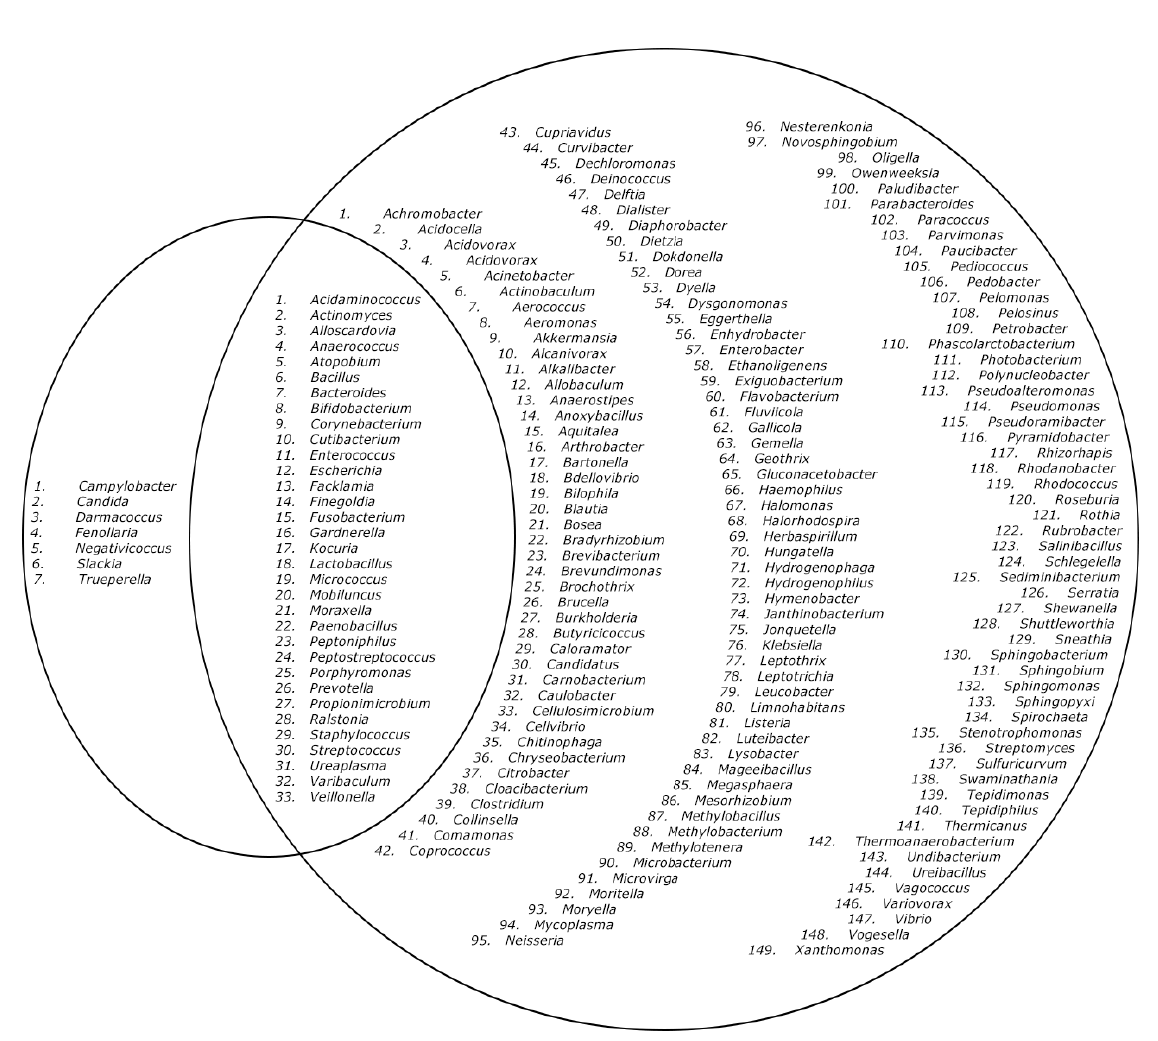
Figure 2. Venn-diagram of the described genera in the endometrium microbiome. Left circle: genera found with our culturomics protocol. Right circle: genera described in the literature [7,16]. Inner circle: genera found in both our study and the literature [7,16]. Literature overview includes both infertile and subfertile women. Table 2. Summary of the 85 different species found in the 10 endometrial biopsies. Detailed information per patient and per species available in Supplementary Table S1.